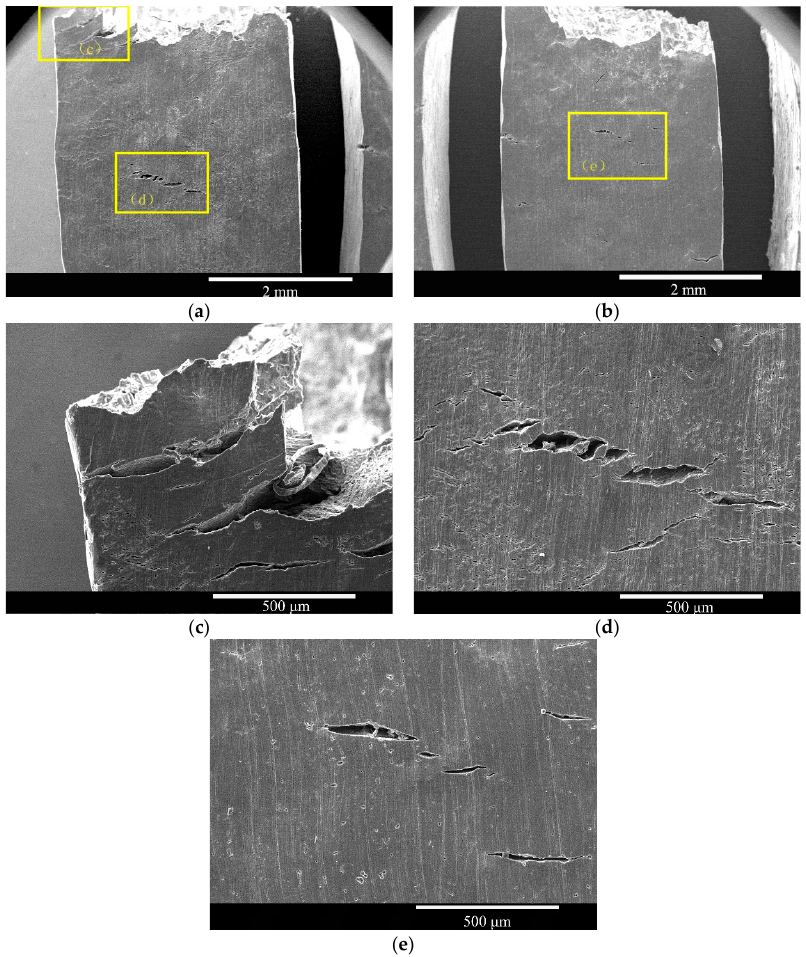
Figure 7. Top-surface morphologies of the ( a , c , d ) as-cast and ( b , e ) solid-solution-treated AM50 magnesium alloy samples corrosion SSRT tested in deionized